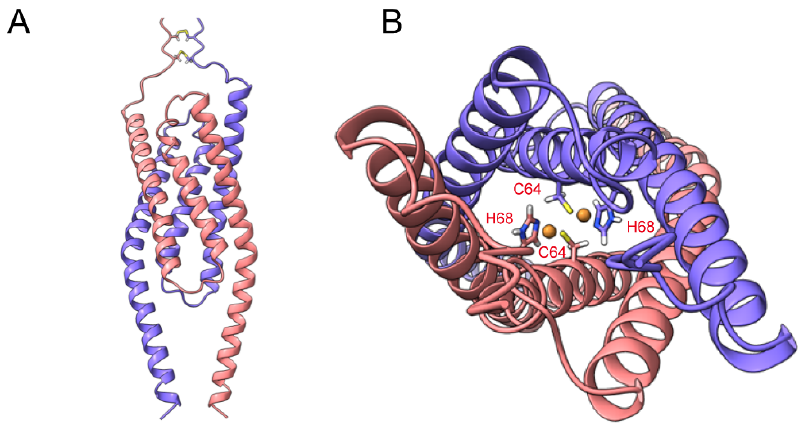
Figure 3. The protein modeling of LeETR2 1–131 using AlphaFold2. ( A ) The side view of the dimeric model of LeETR2 1–131 computed from AlphaFold2. ( B ) The top view of LeETR2 1–131 displaying the orientation of copper ions and copper binding sites C64 and H68, which are facing inward. The individual copper binding sites C64 and H68 of LeETR2 1–131 are depicted as sticks.